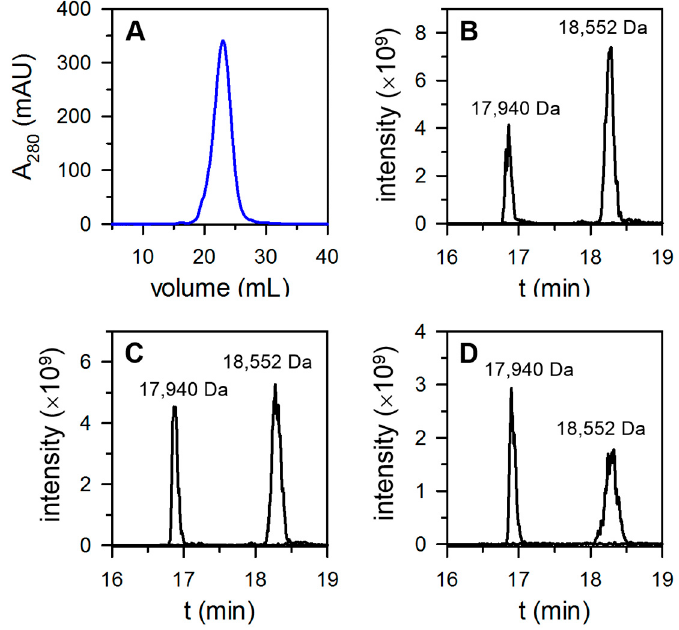
Figure 4. Bfr isolated from P. aeruginosa cultured in 10% O 2 is a mix of 24-mer heterooligomeric protein constituted of FtnA and BfrB subunits of varying content. ( A ) Pure Bfr injected on a Source TM 15Q column eluted in a single, broad peak. The extracted ion chromatograms (EICs) obtained by LC-MS analysis of protein eluted from the Source TM 15Q column in the left ( B ), center ( C ), and right ( D ) portions of the broad peak show the presence of FtnA (17,940 Da) and BfrB (18,552 Da) subunits. The content of FtnA and BfrB in Bfr was estimated from the corresponding integrated peak areas in the EIC, and the values are presented in Table 1.